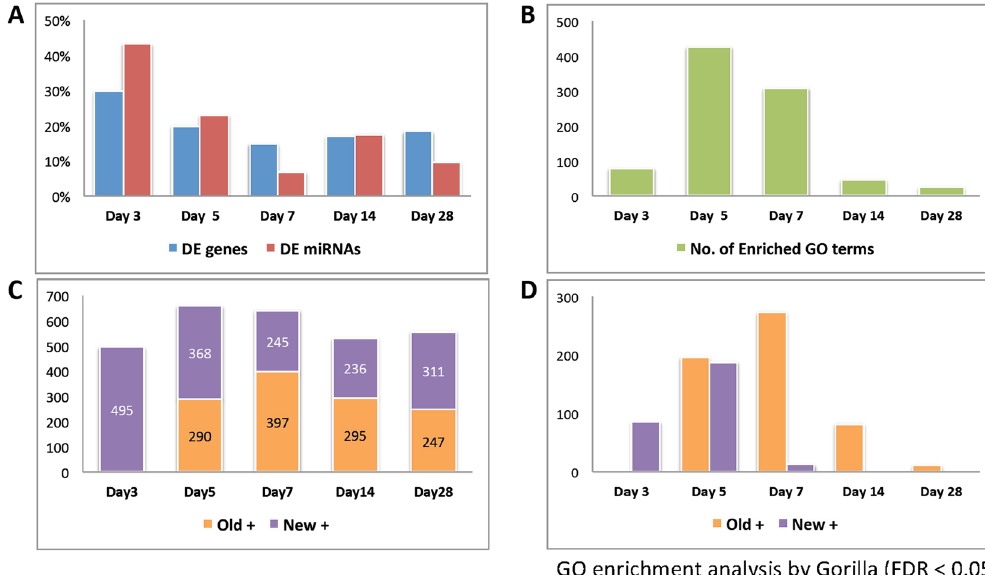
Figure 2. Proportions of differentially expressed (DE) genes and miRNAs and the number of enriched GO terms for DE genes at different time points. ( A ) Proportions of DE genes (blue bars) and miRNAs (red bars) that first time occurred at a time point. ( B ) Number of enriched GO terms for DE genes at a time point. ( C ) Numbers of up-regulated DE genes with first time up-regulation (New + set; purple bars) at a time point and DE genes up-regulated at a previous time point (Old + set; orange bars). ( D ) Numbers of enriched GO terms for DE genes from the New + set (purple bars) and DE genes from the Old + set (orange bars) at a time